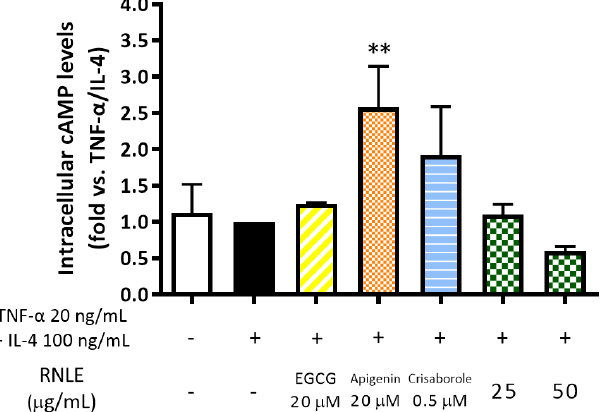
Figure 11. Effect of RNLE treatment (25–50 µg/mL) on intracellular cAMP levels in differentiated HaCaT cells stimulated with a combination of IL-4 and TNF-α (100 ng/mL + 20 ng/mL, 24 h). (−)-Epigallocatechin 3-gallate (EGCG) 20 µM, apigenin 20 µM, and crisaborole 0.5 µM were used as the reference compounds; ** p < 0.01 vs. stimulus.